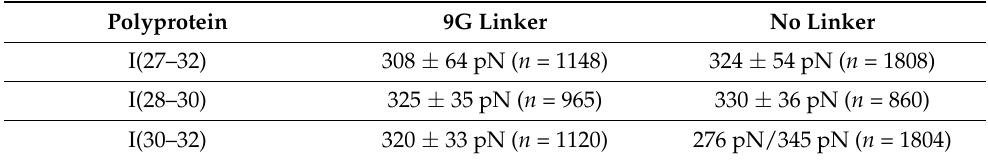
Table 1. Unfolding force of Ig domains for each polyprotein